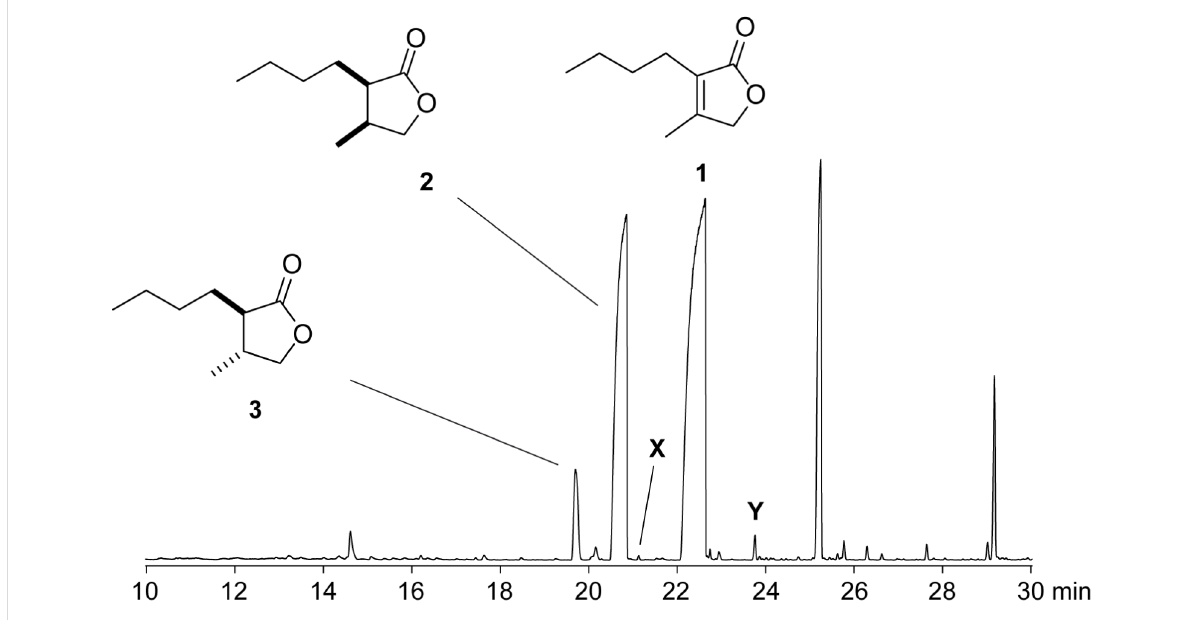
Figure 1: Total ion chromatogram of a CLSA headspace extract from Geniculosporium .